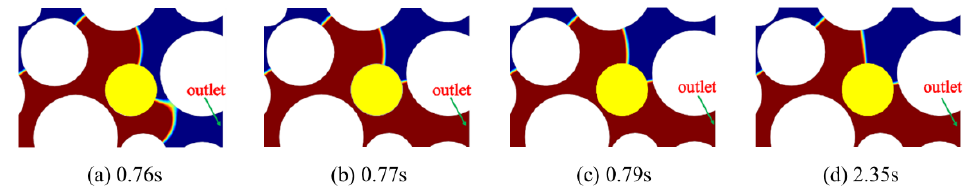
Figure 7. Variations of the CO 2 main channel at different times (log Ca = − 5.62, log M = − 3.00; red and blue regions represent CO 2 and oil, respectively).